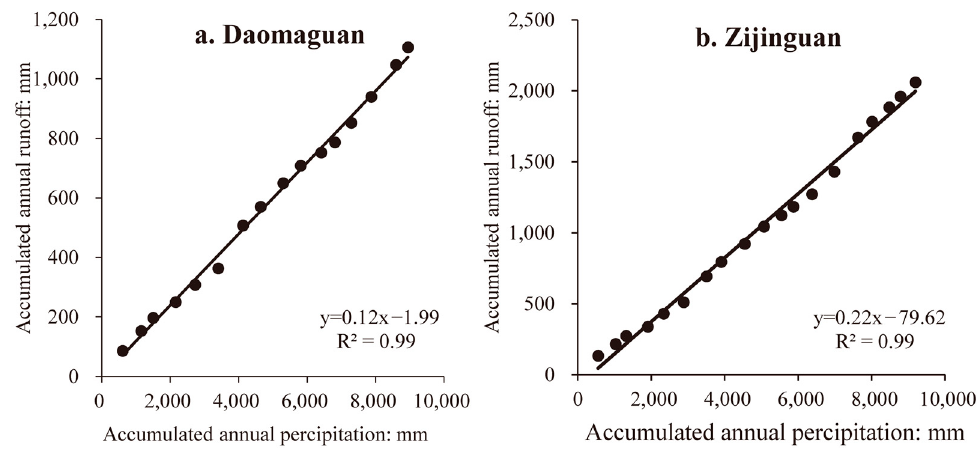
Figure 4. Results of linear regression between accumulated annual precipitation versus accumulated annual runoff from 1982 to 1998 in the ( a ) Daomaguan basin and ( b ) Zijinguan basin.